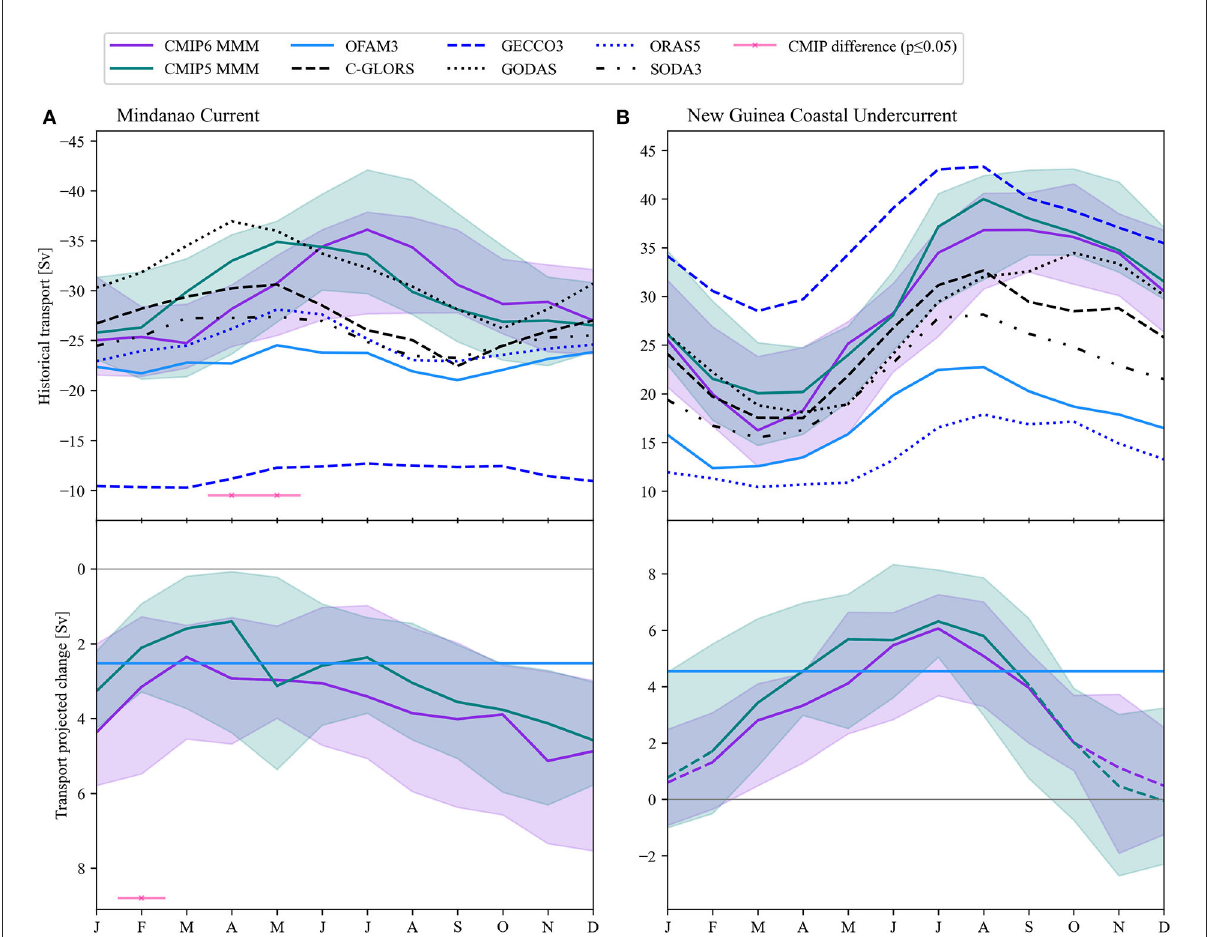
FIGURE3 Monthly transport of the (A) Mindanao Current and (B) New Guinea Coastal Undercurrent in the historical scenario (upper panels) and projected change (lower panels). Shown are CMIP6 (purple) and CMIP5 (green) multi-model median (MMM; solid lines) and interquartile range (shaded), OFAM3 (blue lines) and reanalysis products (black/blue broken lines). MMM projected changes that are not statistically significant are represented by dashed lines. Pink crossed lines indicate where CMIP5 and CMIP6 differences are statistically significant. In (A) , southward direction is represented by negative values ( y -axis reversed), and a corresponding positive projected change indicates a